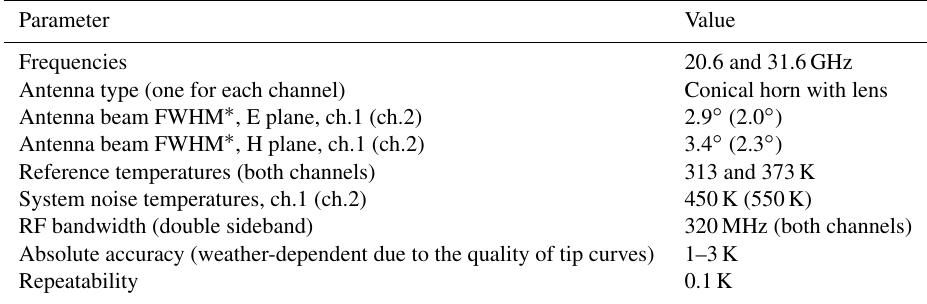
Table 2. Specifications for the Konrad WVR.